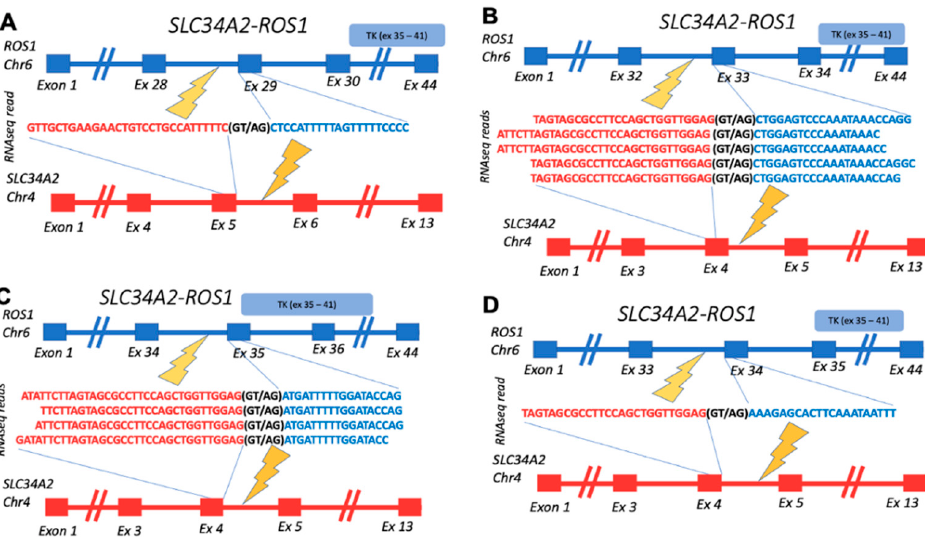
Figure 4. Schematic representation of SLC34A2-ROS1 fusion transcripts identified: ( A ) gene structures upstream and downstream of fusion site for transcript variant 1 (in-frame); ( B ) gene structures upstream and downstream of fusion site for transcript variant 2 (in-frame); ( C ) gene structures upstream and downstream of fusion site for transcript variant 3 (in-frame); ( D ) gene structures upstream and downstream of fusion site for transcript variant 4 (out-frame). TK, ROS1 -encoded tyrosine kinase domain.